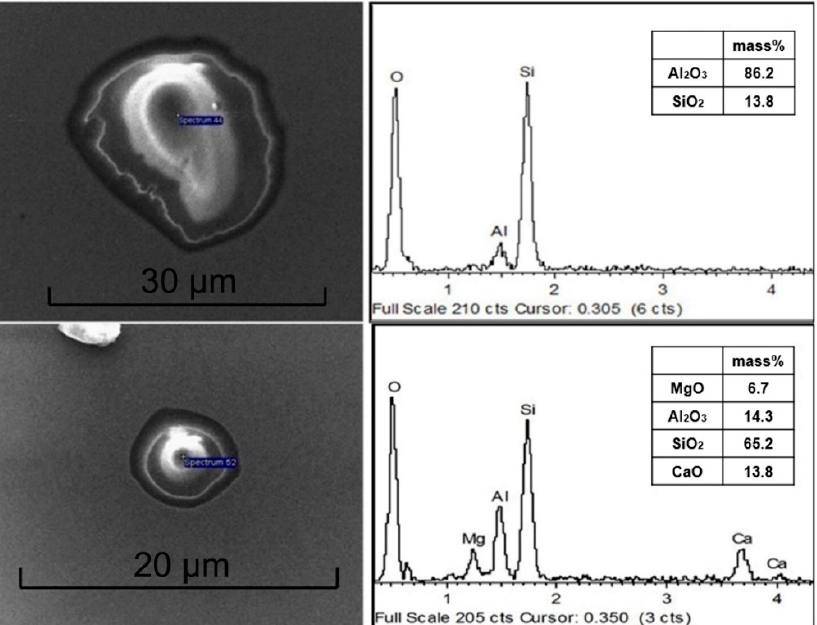
Figure 12. SEM images and EDS results of inclusions in casting slab in the case of calcium addition 1 m/t in LF.